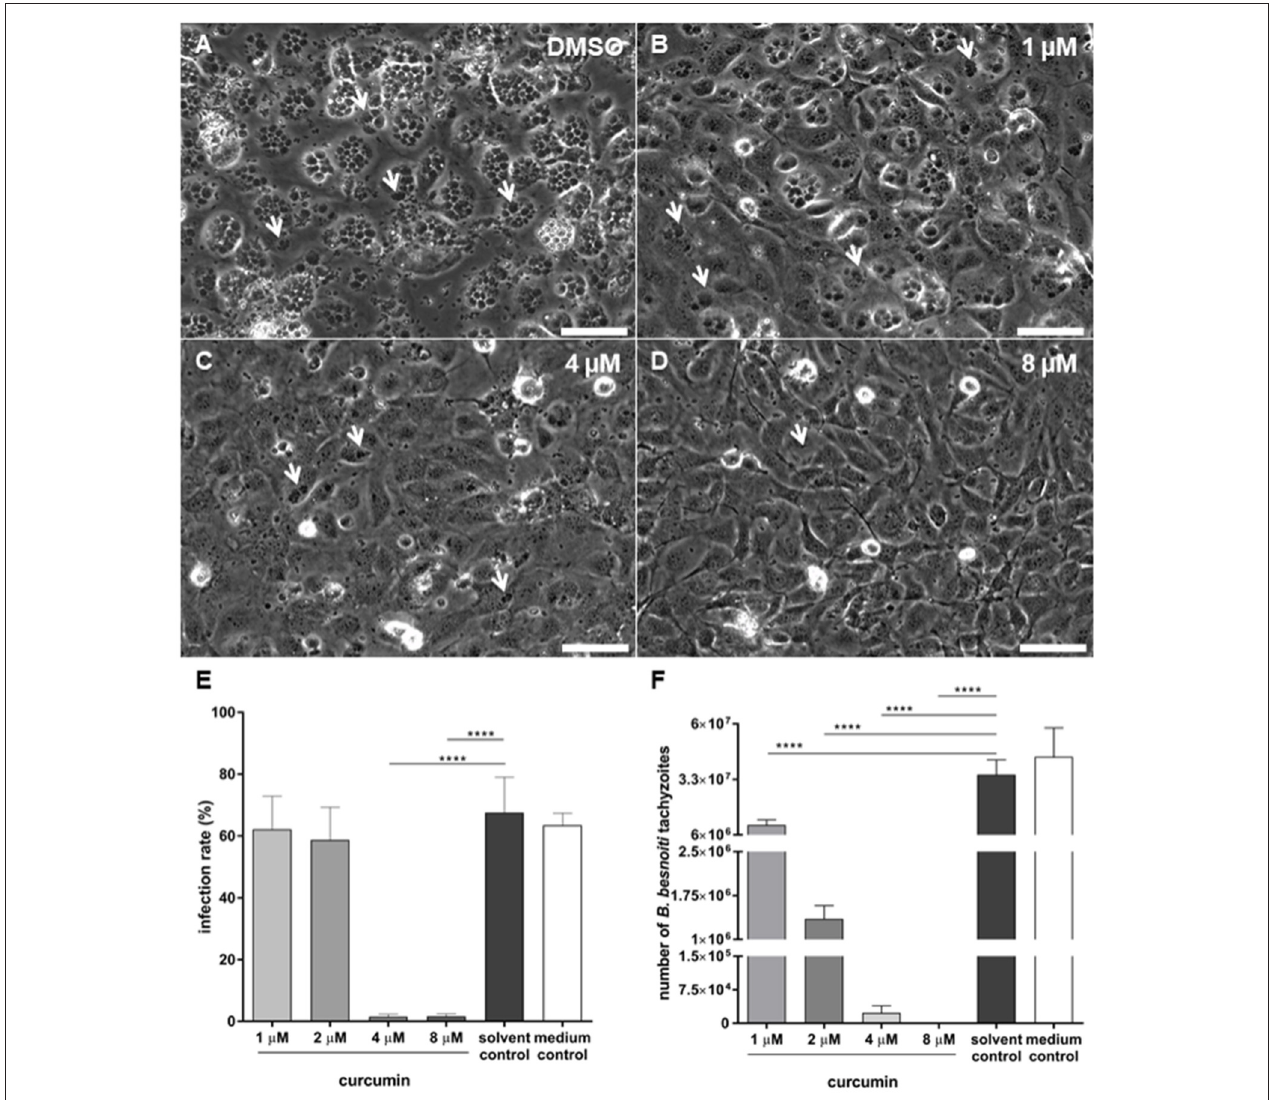
FIGURE 2 | Effects of curcumin pretreatments of Besnoitia besnoiti tachyzoites on infection rate and parasite proliferation in bovine endothelial host cells . B. besnoiti tachyzoites were pretreated with different doses of curcumin (1, 2, 4, and 8 µ M) for 90min and used for bovine umbilical vein endothelial cell (BUVEC) infection [for illustrations, see (A–D) , bar 50 µ m]. At 24h p. i., infection rates were determined microscopically (E) and at 48h p. i. tachyzoite production was analyzed (F) (**** p <